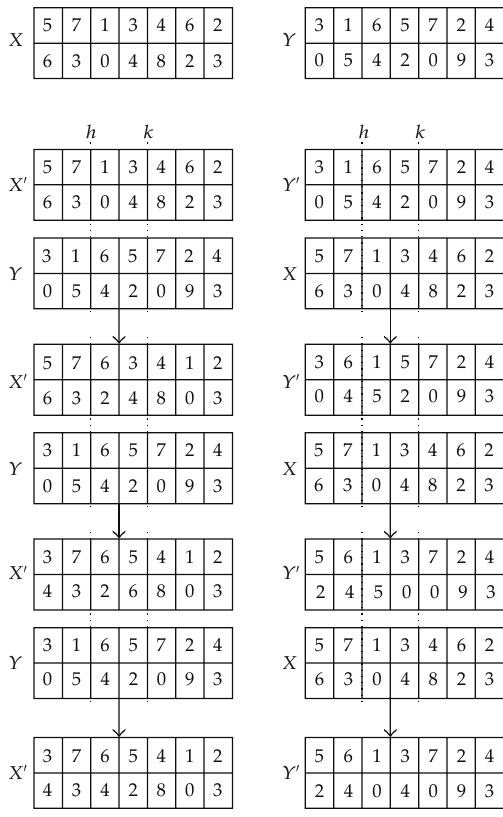
Figure 6: An example of PMX for double string.